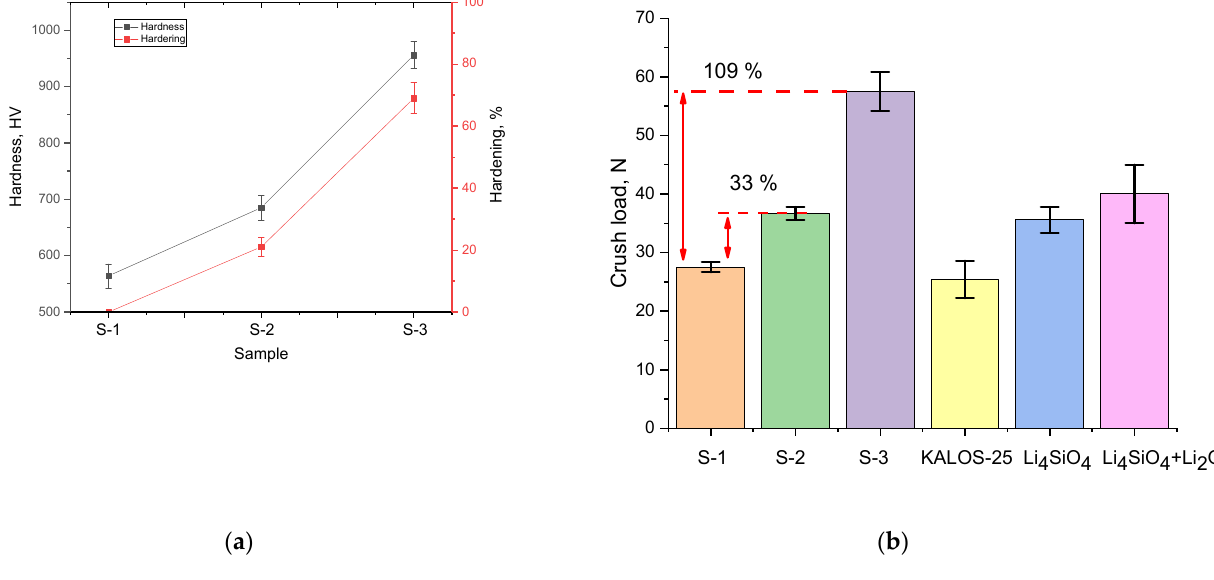
Figure 3. ( a ) Results of changes in the hardness of ceramics during indentation; ( b ) results of changes in the single compression resistance value.